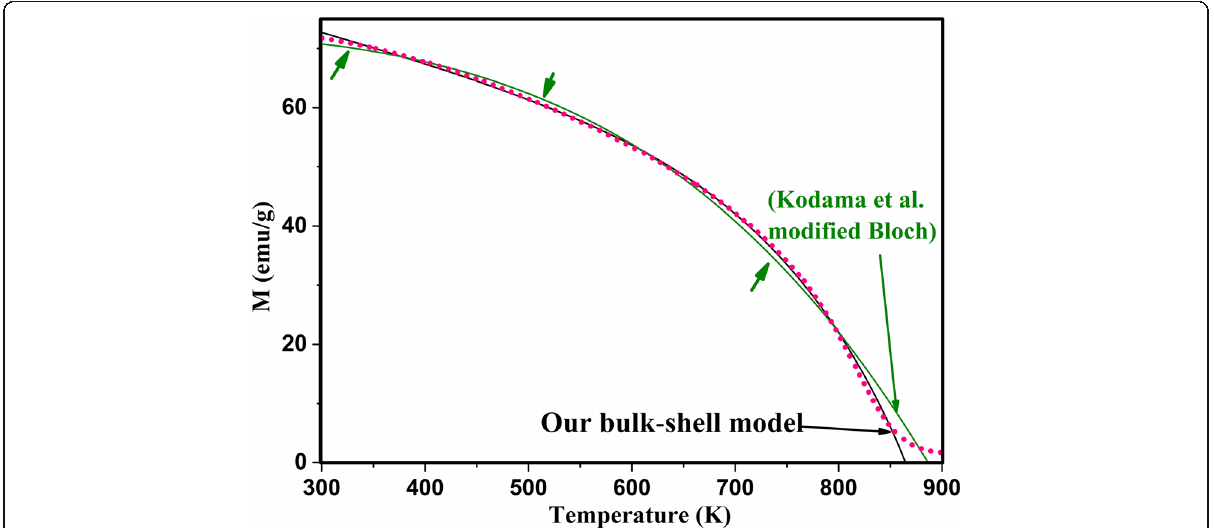
Fig. 14 Change of magnetization ( M ) with temperature during heating for the 3rd cycle of the heated pristine Fe 3 O 4 nanoparticles while applying a magnetic field H = 2 (Tesla) (pink dotted, experimental; solid, fitted using the new bulk-shell expression (black) and the modified Bloch law proposed by Kodama et al. (green)). Green arrows indicate the temperatures where the modified Bloch law proposed by Kodama et al. failed to fully fit the experimental data